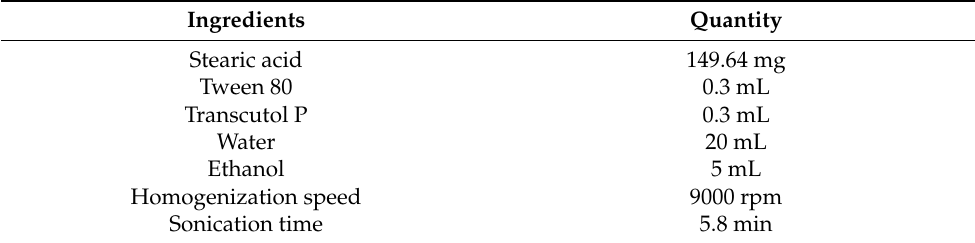
Figure 9. Overlay plot of optimized solid lipid nanoparticle batch using design space. Table 7. Composition of optimized solid lipid nanoparticle batch (CL10) based on design space.